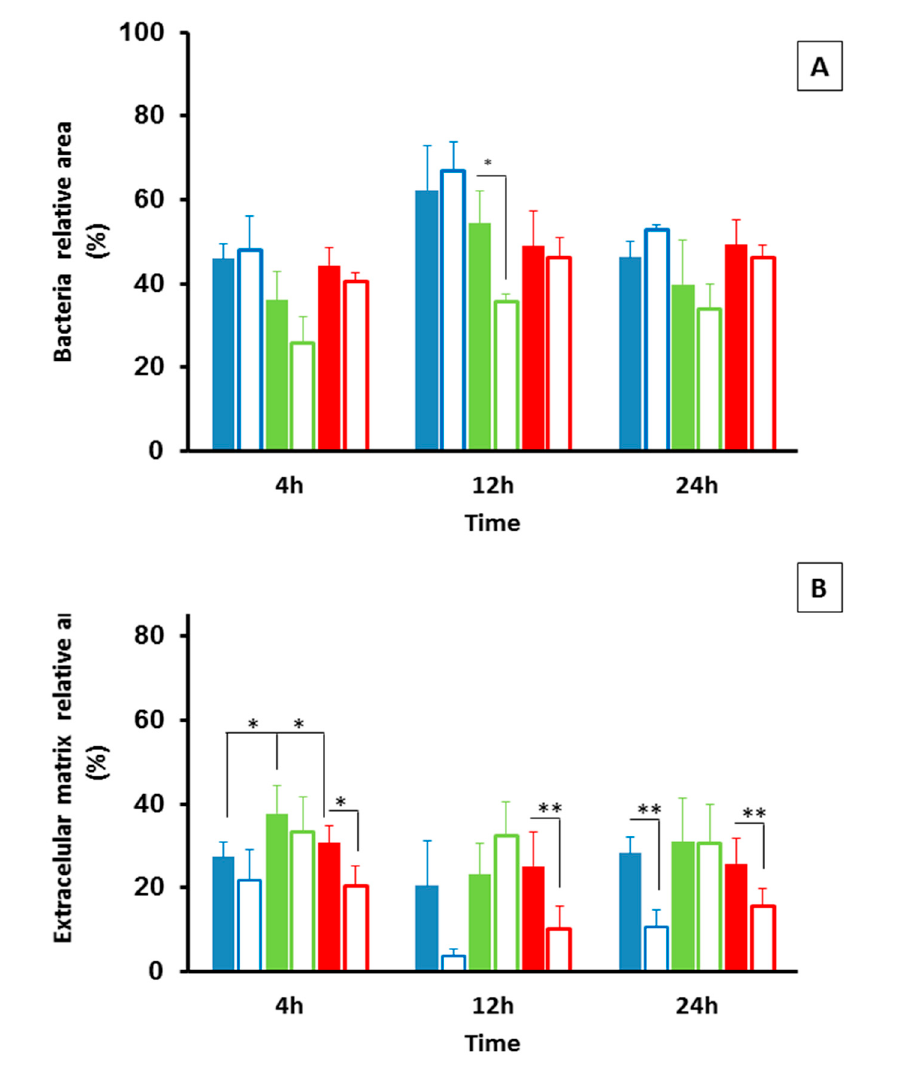
Figure 3. Characterization of K. pneumoniae biofilms assembled on silicone. ( A ) Bacteria; and ( B ) EPS relative areas existent on 4 h, 12 h and 24 h old biofilms assembled on silicone by the three isolates were determined. Bold bars were used for biofilms assembled on silicone and empty bars for biofilms assembled on polystyrene (results from [9]). ( A ) A significant statistical difference in bacteria relative area was observed for 12 h old for Kp45 biofilms assembled on polystyrene and silicone. ( B ) For extracellular matrix relative areas, significant statistical differences were observed for 4 h, 12